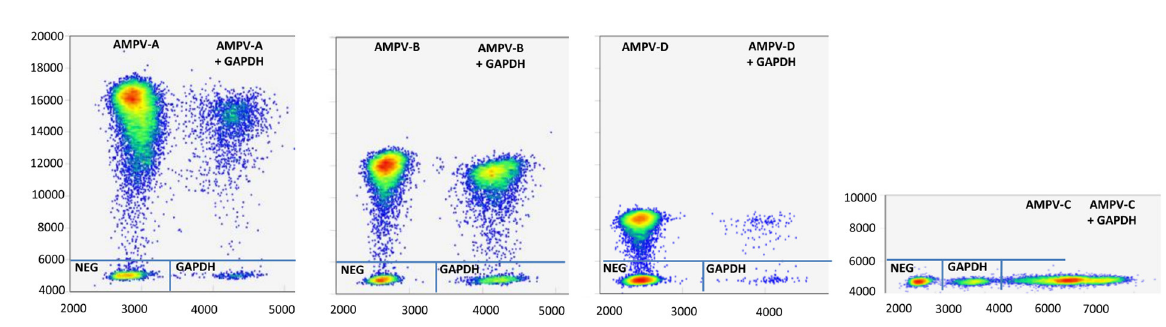
FIGURE2 Graphical representation of the mean amplitude value for each cluster of the five-plex RT-ddPCR AMPV. Amplitude values in channel 1 (CH1, FAM) are represented on Y-axis. Amplitude values in channel 2 (CH2, HEX) are represented on X-axis. Clusters and the standard deviation of their respective amplitude are represented by dots and by lines on this dots, respectively. Statistical differences between AMPV-A, B, and D in CH1 and between AMPV-C and GAPDH in CH2 were determined by Krustall-Wallis tests ( p < 0.0001).